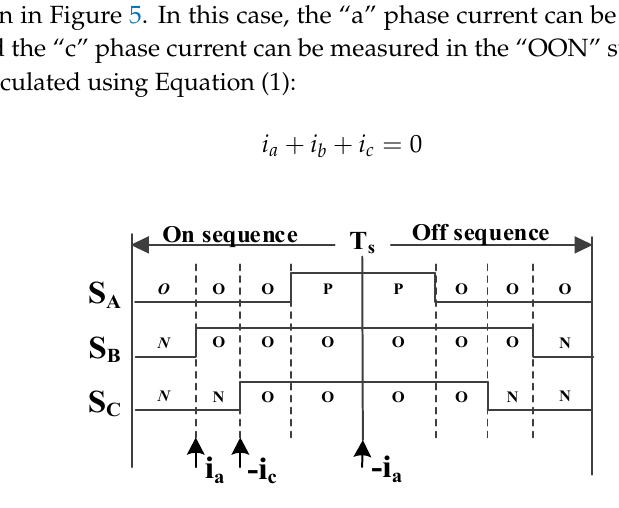
Figure 5. One period of the SVPWM method and sampling point.